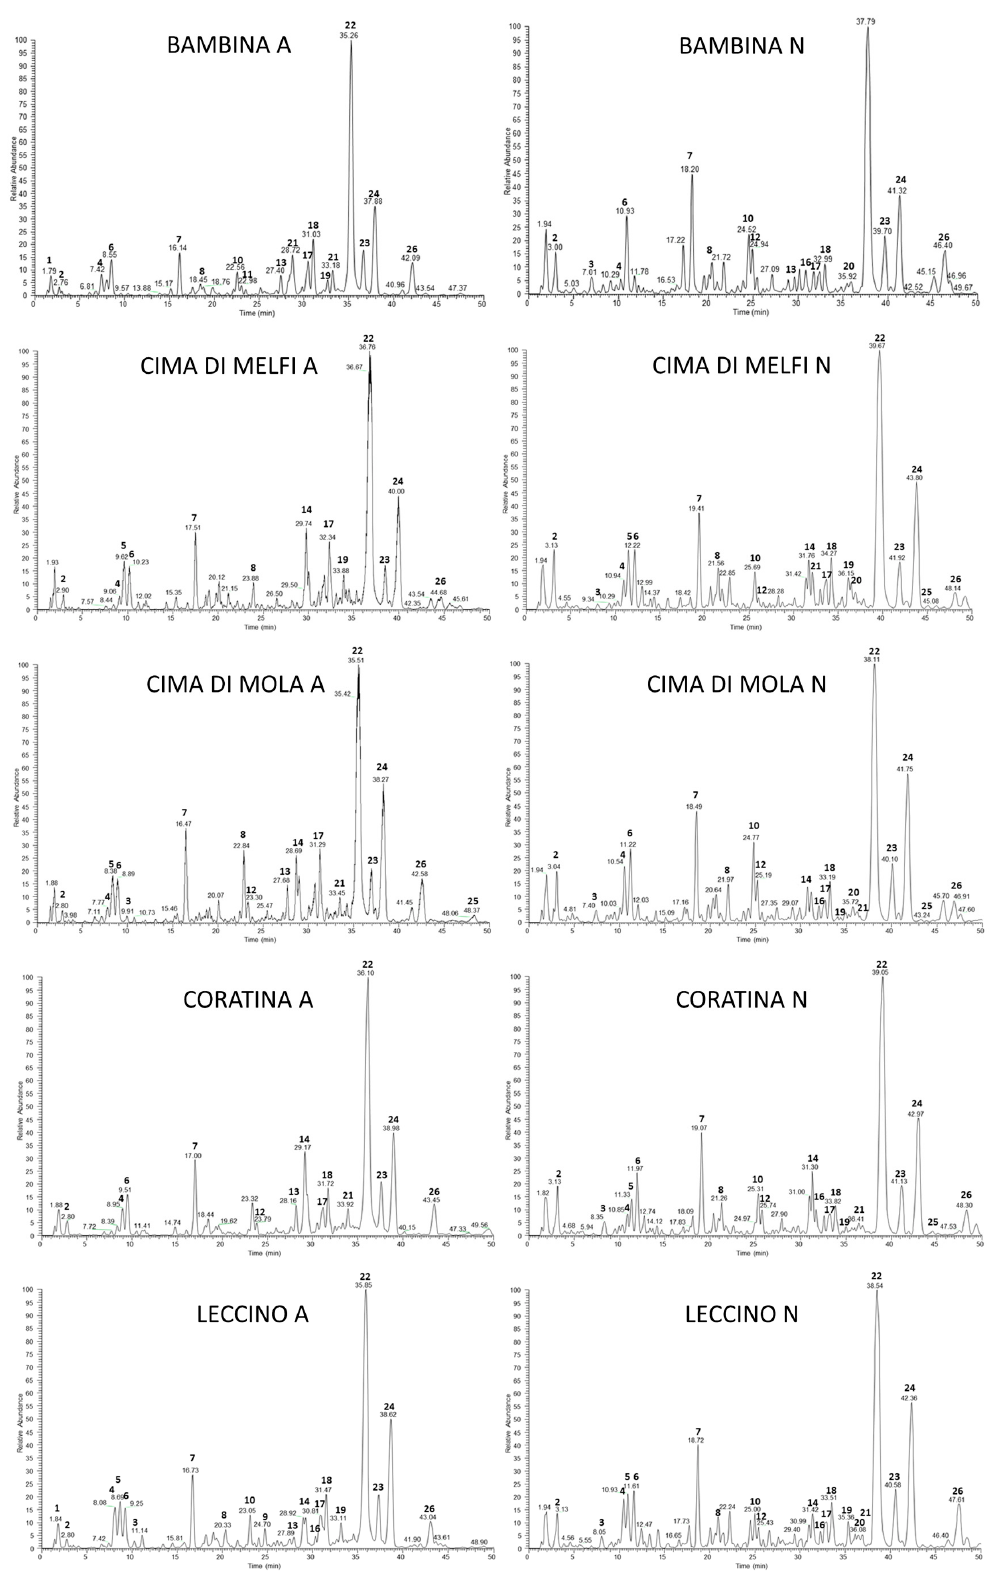
Figure 1. LC-ESI/LTQ-Orbitrap/MS profiles of Olea europea hydro-alcoholic extracts from the Novem- ber (N) and April (A) leaves of Bambina, Cima di Melfi, Cima di Mola, Coratina, and Leccino cultivars (negative